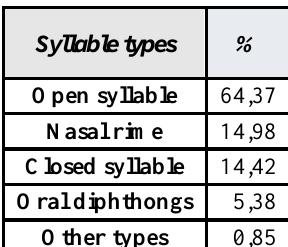
Table 1. Relative frequency of different syllabic types in standard EP